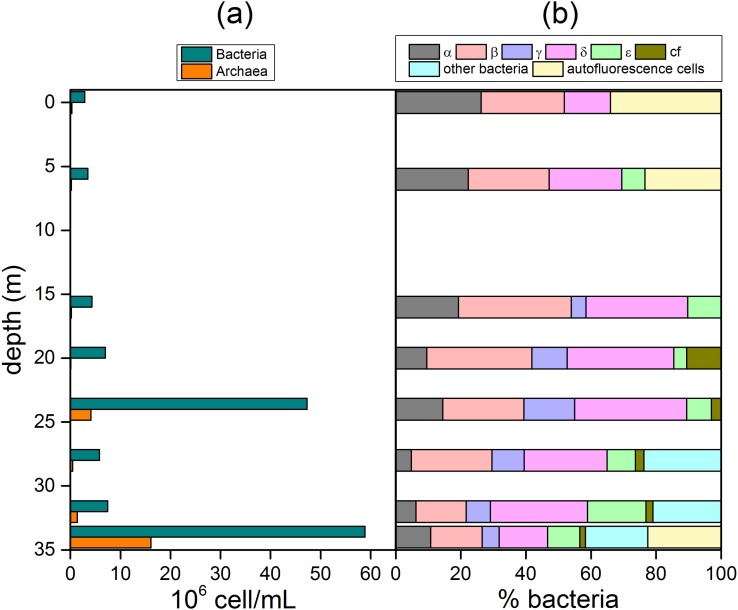
Vertical microbiological profiles along the Lake Averno water column estimated by CARD-FISH.(a) archaea and bacteria (cell ml-1); (b) Proteobacteria (Alpha, Beta, Gamma, Delta and Epsilonproteobacteria), Bacteroidetes-Flavobacteria (cf) and autofluorescent cells (expressed as % of total bacteria).